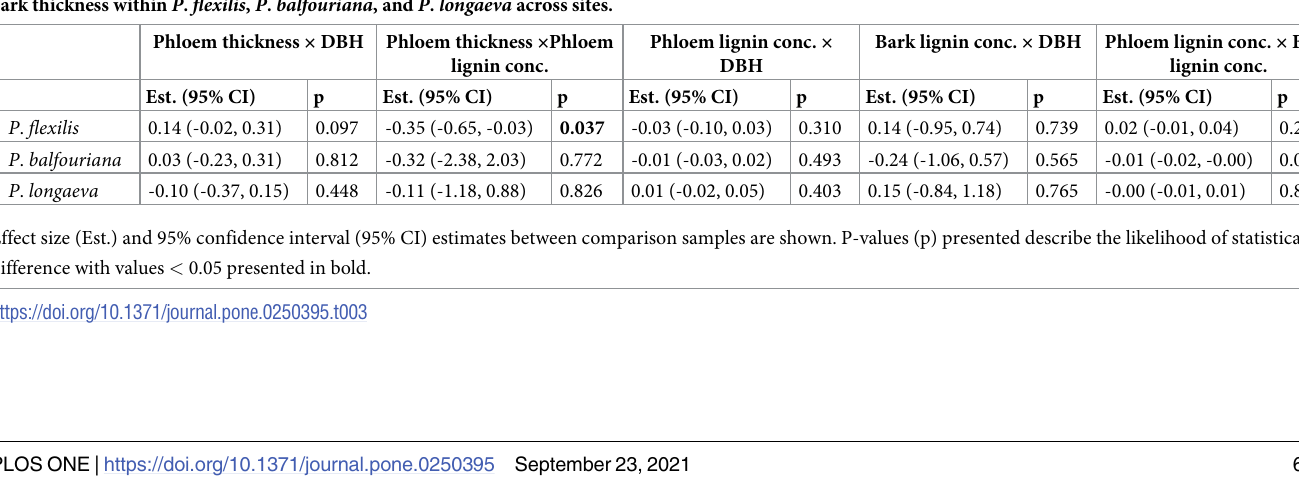
Table 3. Modeled linear regression coefficients (i.e., slope) testing for the relationship between phloem thickness (mm) and DBH (diameter at breast height, cm), phloem thickness and phloem lignin concentrations (mg/g FW), phloem lignin concentrations and DBH, bark lignin concentrations and DBH, and phloem and bark thickness within P . flexilis , P . balfouriana , and P . longaeva across sites.